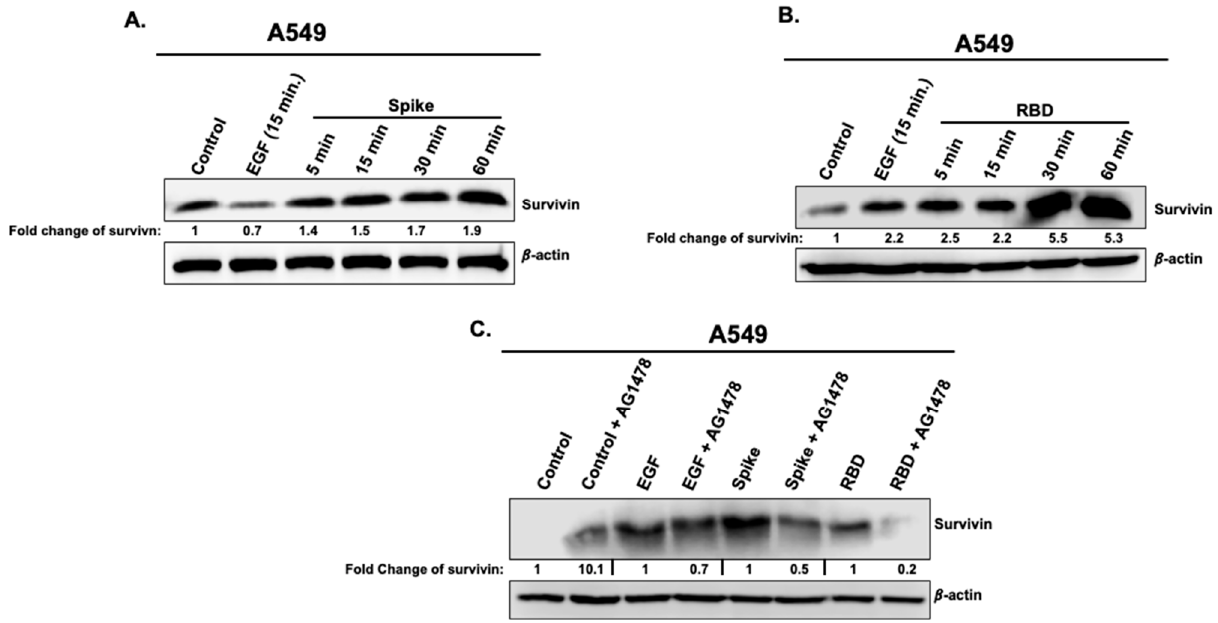
Figure 5. SARS-CoV-2 full length spike 1 protein and its RBD promote survivin expression in A549 cells. A549 cells were treated or not with EGF (5 µg/mL) ( A , B ), full-length spike 1 protein (2.5 µg/mL) ( A ) or spike RBD protein (5 µg/mL) ( B ) at different times (5, 15, 30 and 60 min) as indicated and the protein level of survivin was determined by Western blot. ( C ) A549 cells were first pre-treated or not with AG1478 (10 µM) for 15 min prior to treatment with EGF (5 µg/mL) or spike RBD protein (5 µg/mL) and the protein level of survivin was determined as described above.